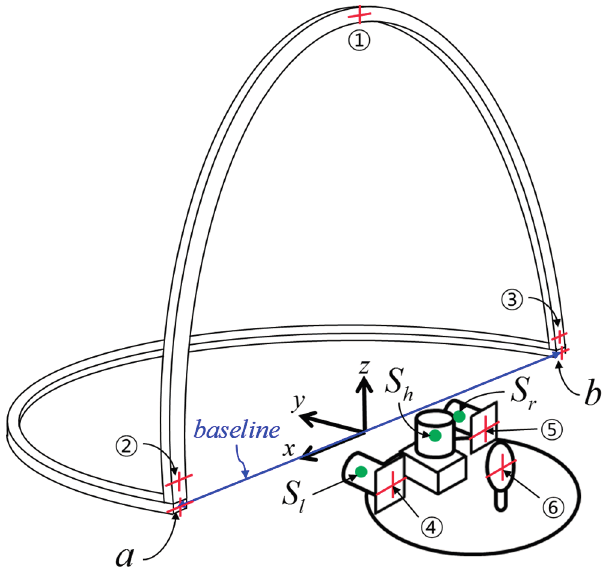
Figure 8. Temporary coordinate system for